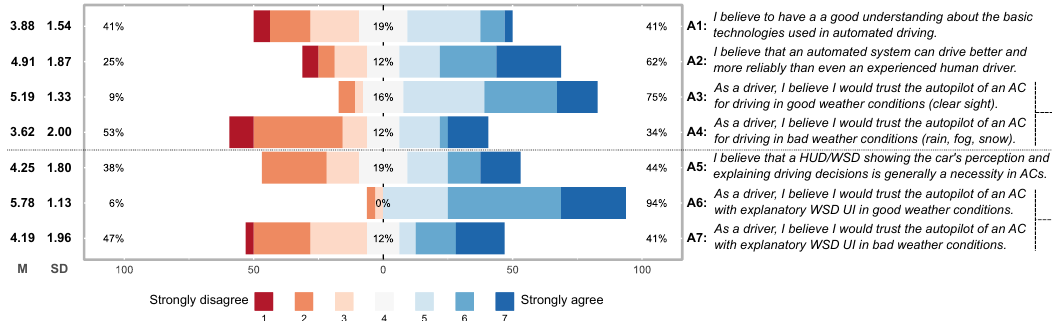
Figure 7. Results from the pre-test opinions given before the detailed briefing about the main study tasks. Participants were (textually and visually) introduced to the concept of explanatory UIs after A4 . The dashed line marks items that allow pre-post comparison regarding introduction of the UI